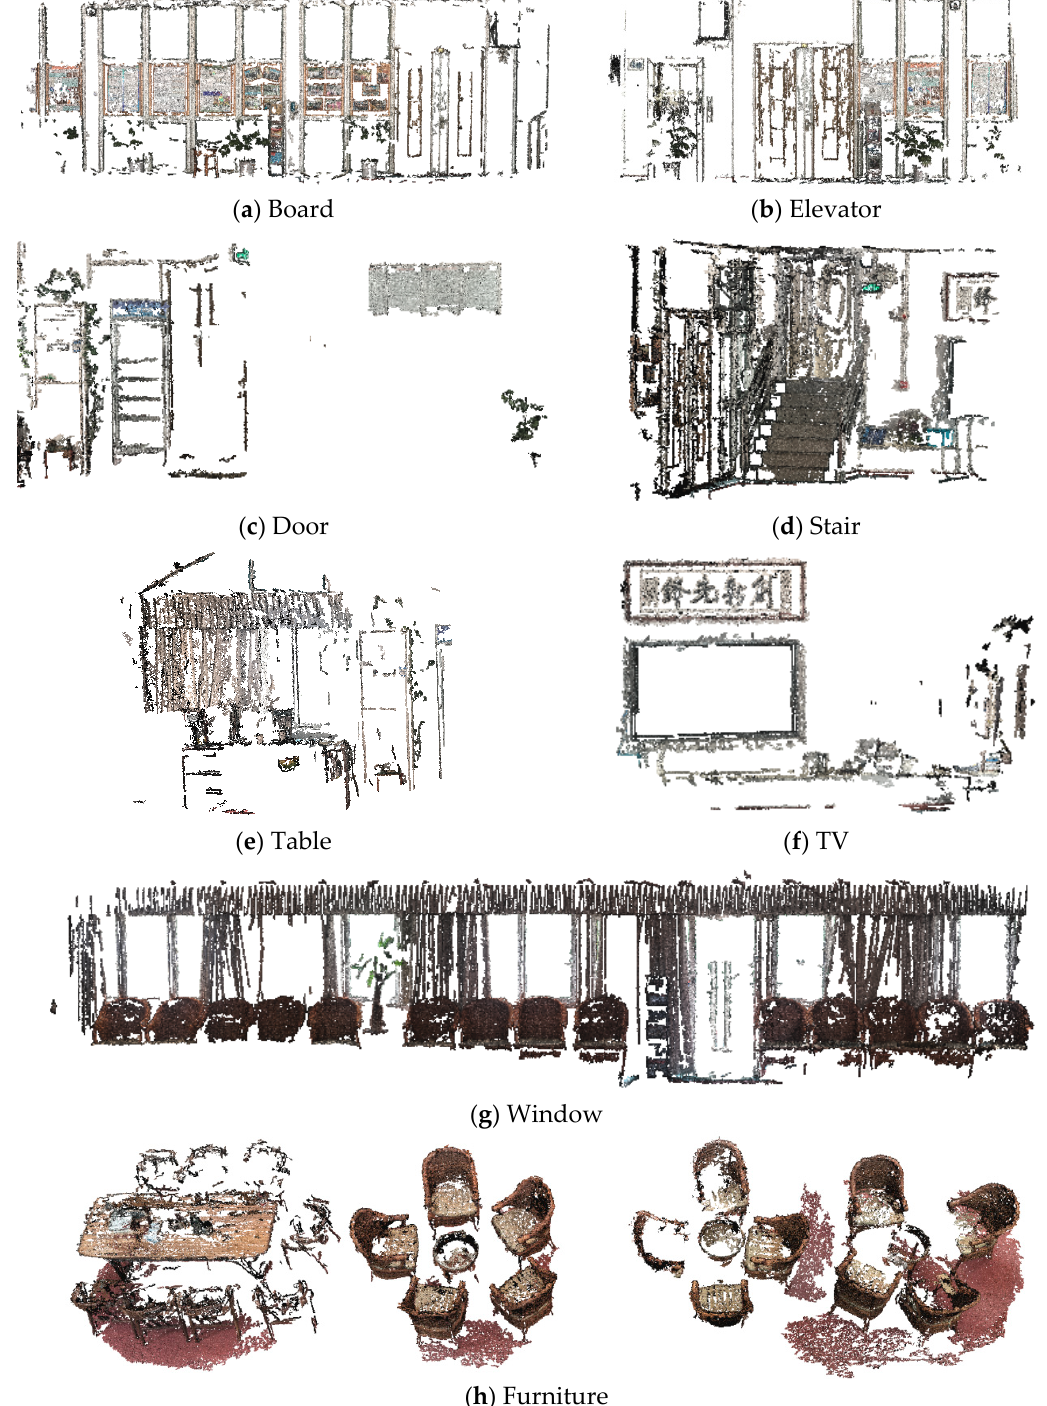
Figure 4. ( a )–( h ) The reconstructed atomic models of each class. Figure 4. ( a – h ) The reconstructed atomic models of each